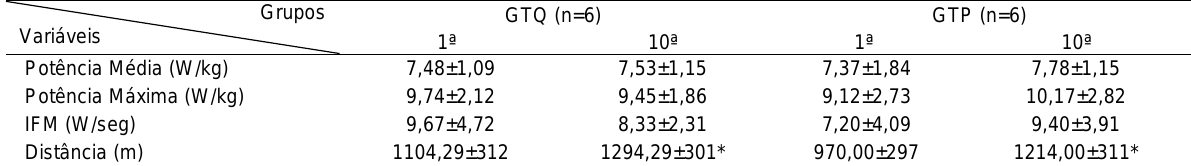
Tabela 2. Resultados médios e desvio padrão do RAST (Potência Média, Potência Máxima e Índice de Fadiga Muscular - IFM) e do Yo-yo Intermitent (Distância) antes da 1ª e depois da 10ª sessão de treino para o GTQ e o GTP.